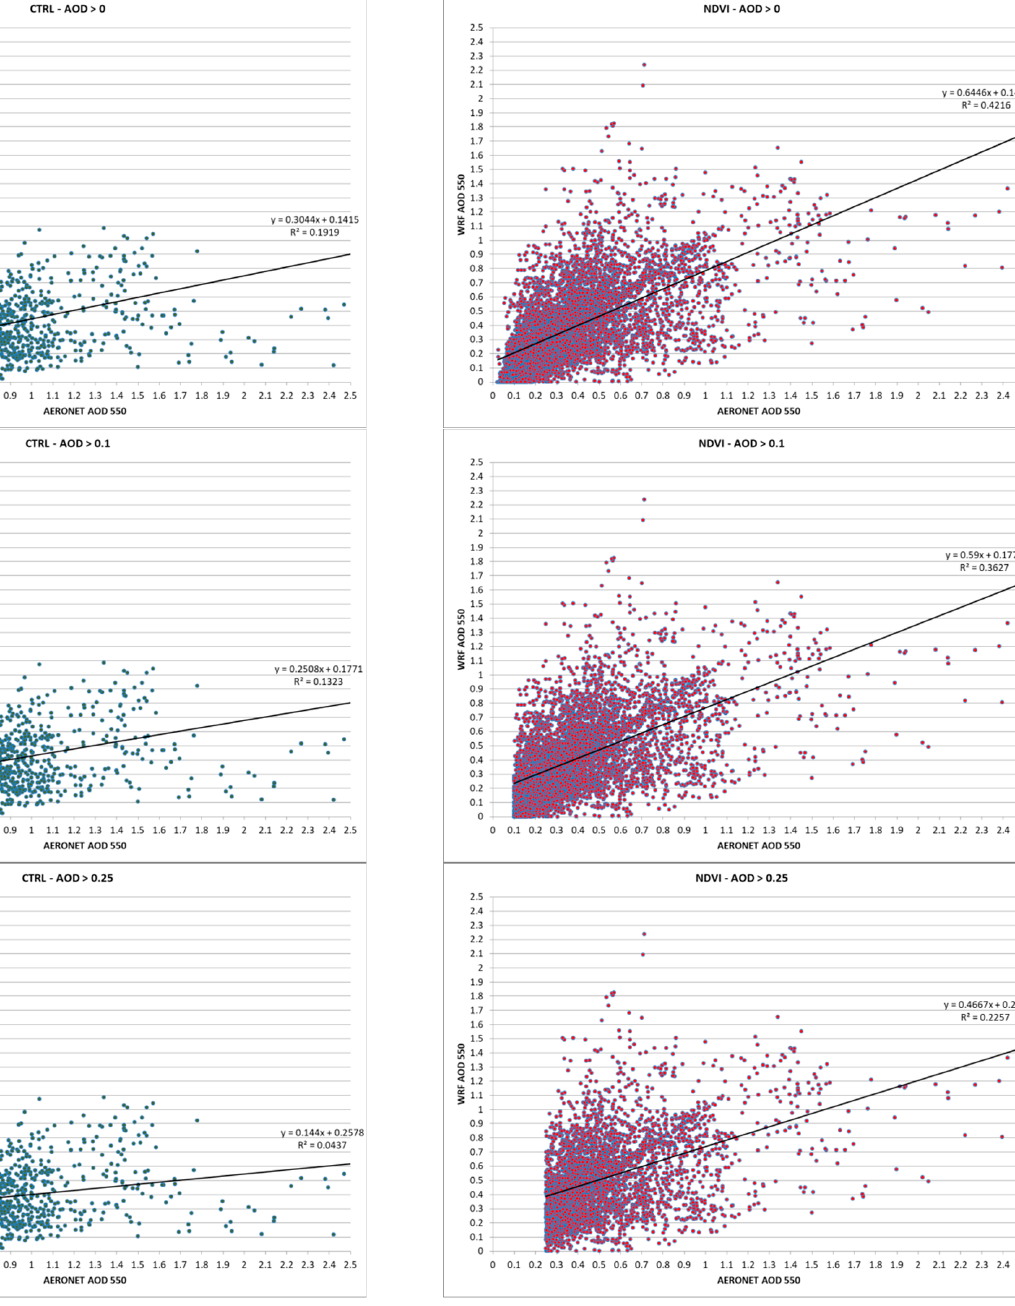
Figure 5. Scatterplots of Modeled AOD and AERONET data for all stations and for WRF-CTRL ( left ) and WRF-NDVI ( right ) simulations. Results are presented for three AOD limits: AOD > 0.0 ( top ), AOD > 0.1 ( middle ), and AOD > 0.25 ( bottom ).